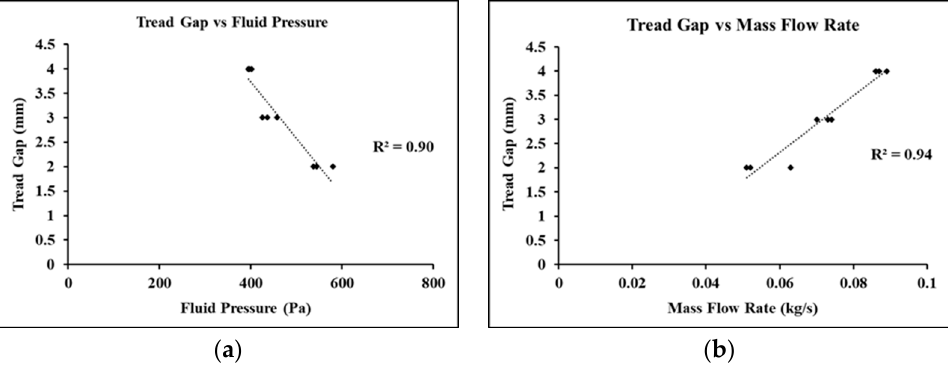
Figure 12. Effect of tread gap on: ( a ) induced fluid pressure and ( b ) mass flow rate.